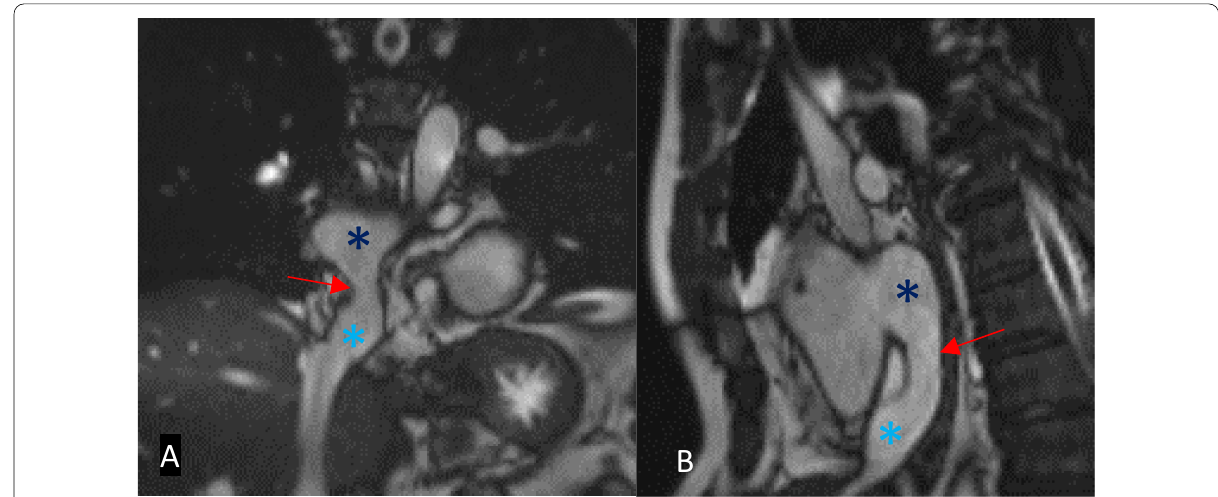
Fig. 20 Still-shot MRI SSFP cine images in the coronal ( A ) and sagittal ( B ) plane post-atrial switch for D-TGA. Baffle leak representing a large and broad tunnel from the IVC to the right atrium with a right-to-left shunt (Qp/Qs asterisk: IVC channel; red arrow: baffle